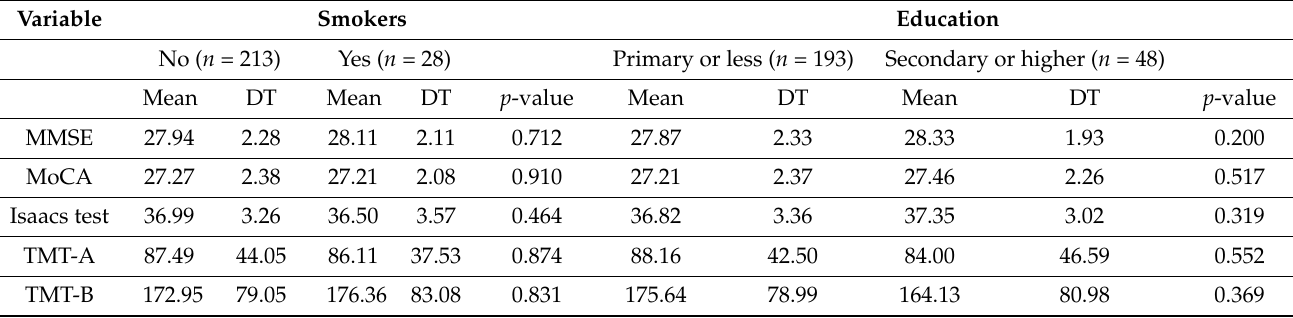
Table 4. Individual differences regarding smoking habit and